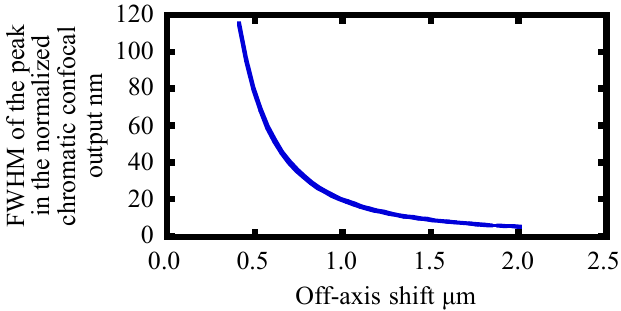
Figure 9. Variation of the full width at half maximum (FWHM) of the peak in the normalized chromatic confocal output estimated by the numerical calculations.